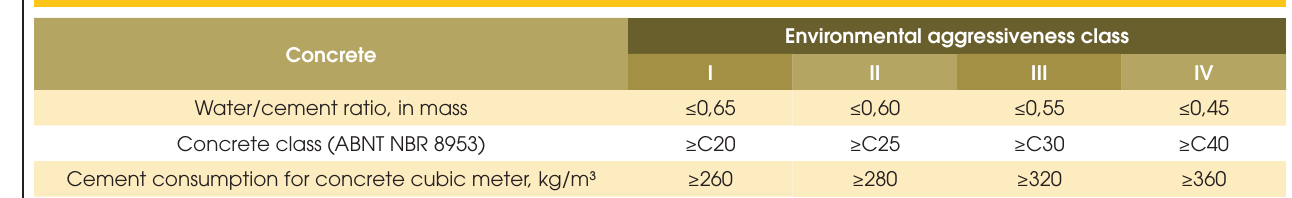
Table 4 – Correspondence between environmental aggressiveness class and concrete quality, for reinforced concrete structures